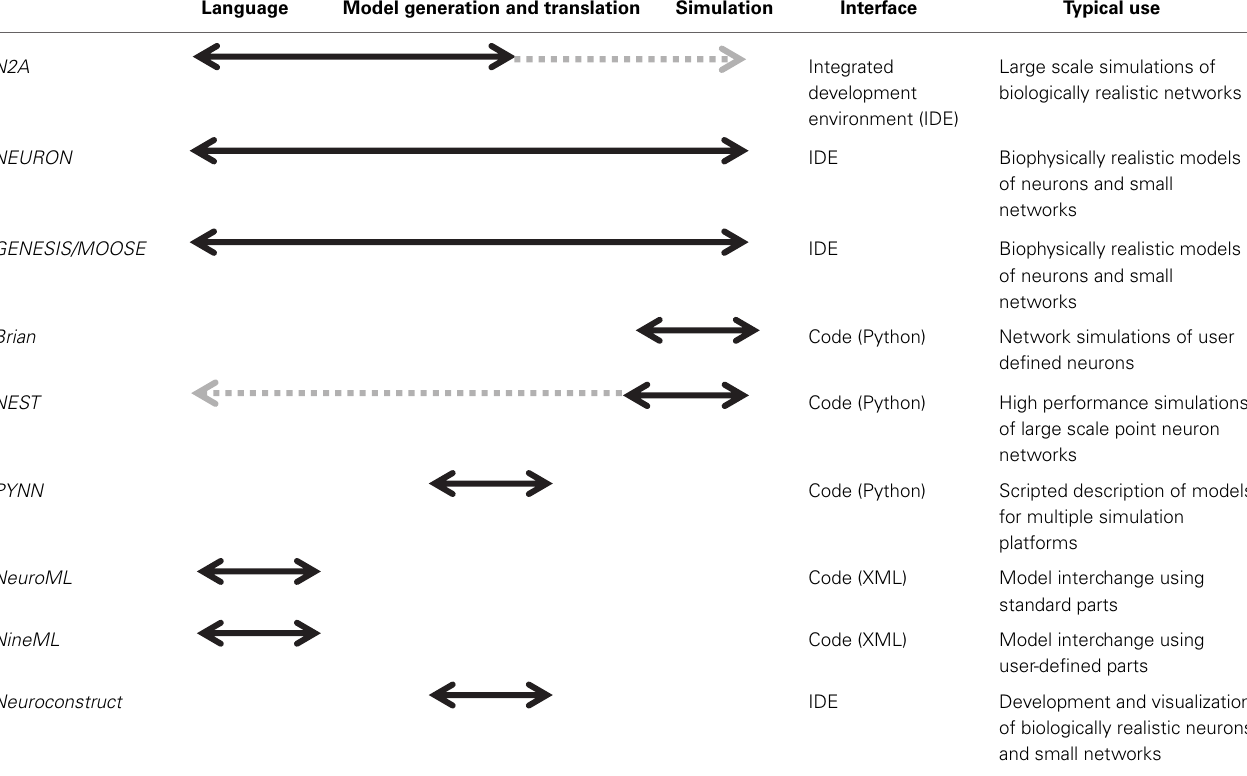
Primary scope is illustrated by bold arrows, with limited capabilities shown by shaded